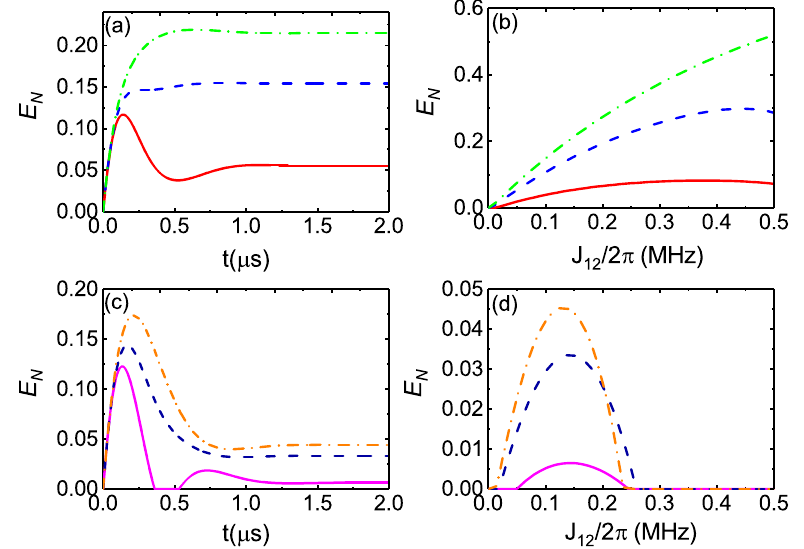
Figure 5. Logarithmic negativity E N between the cavity and mechanical modes affected by the phase difference φ . ( a ) Time evolution of the logarithmic negativity E N between the cavity mode a 1 and mechanical mode b 2 with J 12 /2 π = 0.15 MHz for φ = 0, π /2, and π . ( b ) Stationary logarithmic negativity E N between the cavity mode a 1 and mechanical mode b 2 as a function of J 12 /2 π for various phase differences. ( c ) Time evolution of the logarithmic negativity E N between the cavity mode a 2 and mechanical mode b 1 with J 12 /2 π = 0.15 MHz for φ = 0, π /2, and π . ( d ) Stationary logarithmic negativity E N between the cavity mode a 2 and mechanical mode b 1 versus the J 12 /2 π for various phase differences. Here, the solid line, dashed line, and dash-dotted line represent φ = 0, π /2, and π , respectively. The other parameters are the same as those in Figure